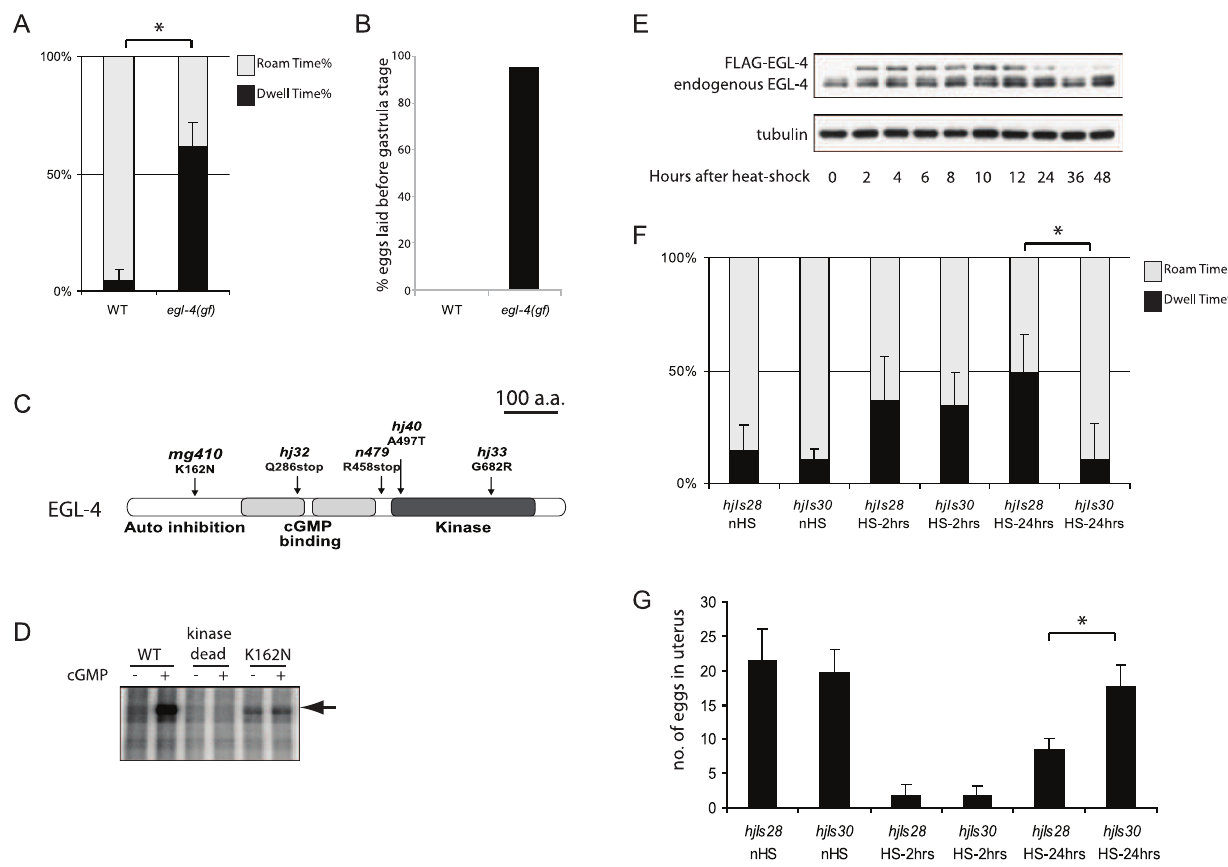
Figure 1. EGL-4/PKG controls foraging behavior and egg laying. (A) Foraging behavior of wild-type and egl-4(gf) mutant animals were monitored in 15-minute intervals. The percentage time roaming or dwelling of each animal was quantitated using the Worm Tracker program. 5 animals were monitored in each trial. Total number of trials: n=25 (wild type); n=19 ( egl-4(gf) ). (Mean 6 SD; pair-wise t-test, *, p , 0.05 ). (B) Percentage of eggs laid prior to gastrula stage within a 1-hr period. Total number of adult animals (total number of eggs observed): wild type= 10(108); egl- 4(mg410) = 20(77). (C) Schematic representation of EGL-4/PKG. Mutant alleles together with corresponding changes in the protein coding sequence in the EGL-4A isoform are indicated. (D) Autoradiograph from an in vitro kinase assay with wild-type (WT) and mutant forms of EGL-4 that were expressed in Drosophila S2 cells. Arrow indicates auto-phosphorylated EGL-4 that is absent in the kinase dead control. (E) Expression level of EGL-4 in lysates prepared from transgenic animals carrying hjIs28[hsp::3xFLAG::EGL-4(K162N)::SL2::mCherry] at specified time after heat shock at 33 u C for 30 mins. Endogenous and FLAG-tagged EGL-4 protein was detected using anti-EGL-4 antibody. The a -tubulin blot served as loading control. (F) Foraging behavior of wild-type animals carrying the transgene hjIs28[hsp::3xFLAG::EGL-4(K162N)::SL2::mCherry] that expressed constitutively active EGL-4 or hjIs30[hsp::3xFLAG::EGL-4(K499A)::SL2::mCherry] that expressed kinase-dead EGL-4. Quantitation of behavior was performed as in (A). Total number of trials: n=6 (non-heatshock (nHS) control and 2 hrs after heatshock (HS-2hrs)); n=13 (24 hrs after heatshock (HS-24hrs)). (Mean 6 SD; pair- wise t-test, *, p , 0.05 ). (G) Number of eggs retained in uterus in transgenic animals carrying hjIs28 or hjIs30 . 24 hrs after heatshock, significantly fewer eggs were retained in animals in which constitutively active EGL-4 had been ectopically expressed ( hjIs28 ), indicating a faster egg-laying rate. Total number of animals for each strain at each time point: n=20. (Mean 6 SD; pair-wise t-test, *, p , 0.05 ) doi:10.1371/journal.pgen.1002065.g001 S1E). Third, loss of saeg-1 or saeg-2 function did not drastically alter egl-4 mRNA levels and more importantly, endogenous EGL-4 protein level remained constant (Figure S2A and S2B). Since there is no phenotypic difference between egl-4(gf) ; saeg-1 , egl-4(gf) ; saeg-2 and egl-4(gf) ; saeg-1 ; saeg-2 mutant animals (Figure 2A, Table 1), we conclude that saeg-1 and saeg-2 act in the same genetic pathway. We isolated four recessive alleles of saeg-1 . Molecular cloning revealed that saeg-1 encodes a C2H2 zinc-finger protein that also contains the conserved ELM2 [38] and SANT domains [39] (Figure 2B). Based on sequence homology and molecular architecture, SAEG-1 is orthologous to human transcriptional regulating factor 1 (TRERF1; Gene ID: 55809) and zinc-finger suppressed excessive dwelling, accelerated egg laying rate and short protein 541 (ZNF541; Gene ID: 84215) [40,41]. We generated a body length of egl-4(gf) animals (Figure 2A, Table 1). Second, loss of rescuing transgene using 29 kb of genomic sequence that saeg-2 function suppressed the behavioral phenotypes triggered by encompassed the saeg-1 gene and inserted the green fluorescent ectopic expression of a constitutively active EGL-4 (Figure S1D and